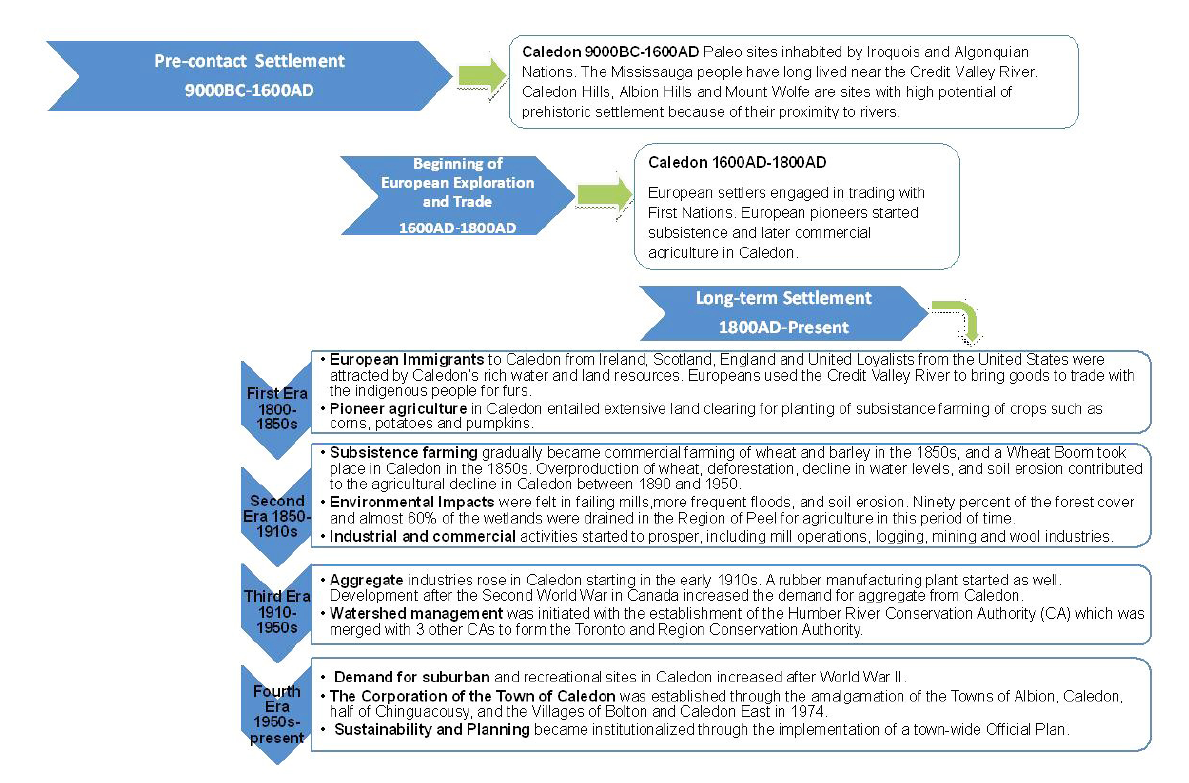
Fig. 6. Historical timeline of Caledon, verified by the former and the working Heritage Officer of the Town of Caledon in 2011 (Sources: Algonquin Associates 1993, Ross 1999, Markvart 2009; interview with a former Heritage Officer of Caledon held on 10 September